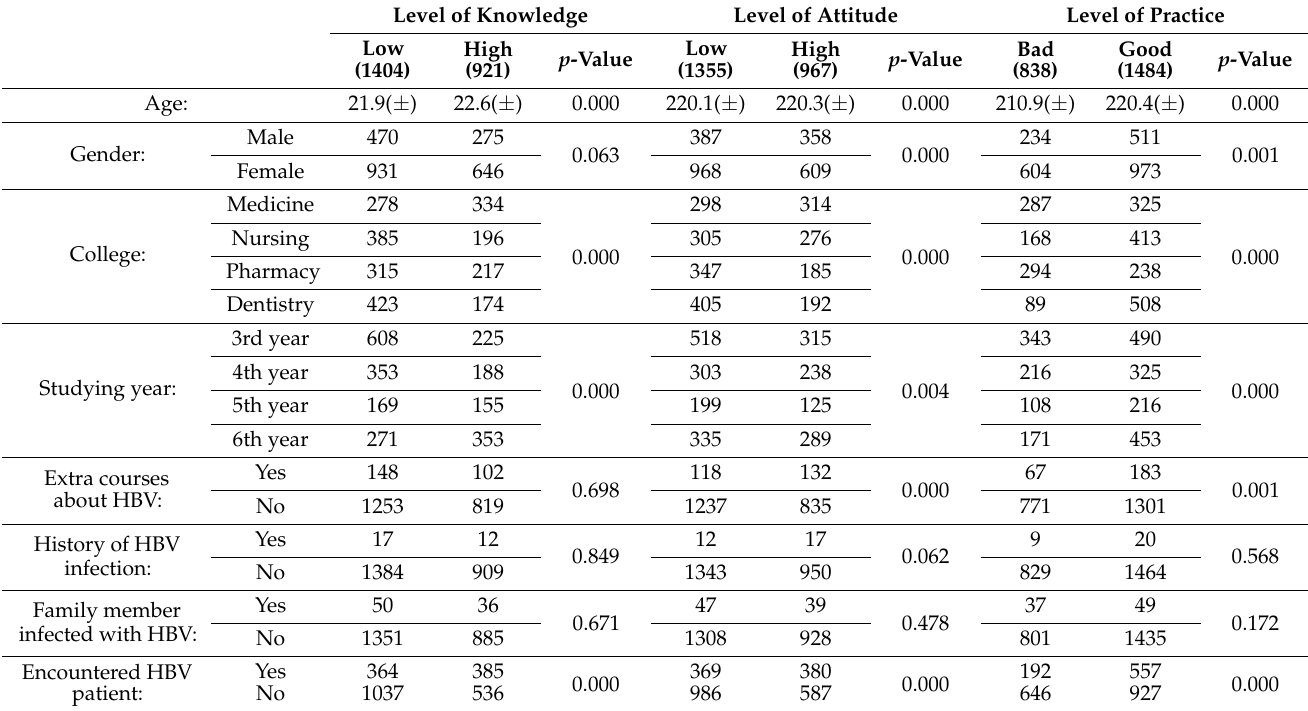
Table 2. Association between demographic characteristics of students and knowledge, attitudes, and practices toward HBV ( n = 2322). Level of Knowledge Level of